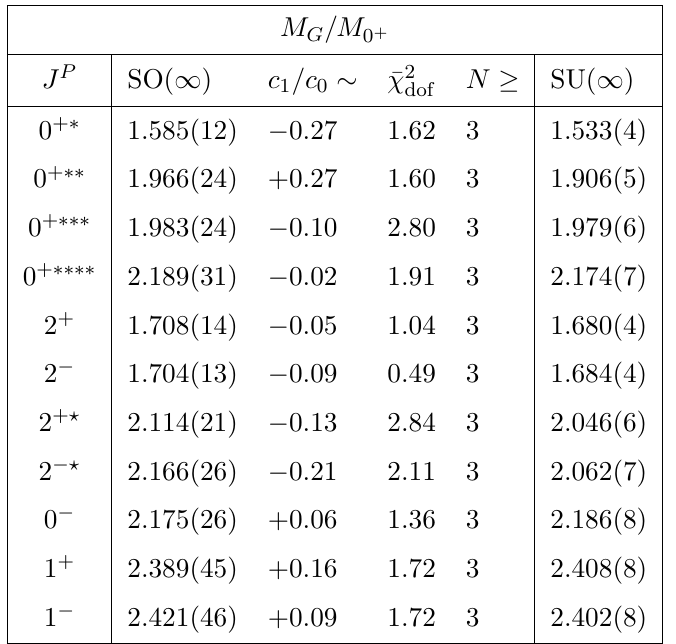
Table 32 . Continuum glueball masses in units of the scalar glueball mass extrapolated to N = 1 , with the (cid:31) 2 per degree of freedom and range of the best linear (cid:12)t c 0 + c 1 =N shown. The values for SU( N ) are from [16]. Grades as in table